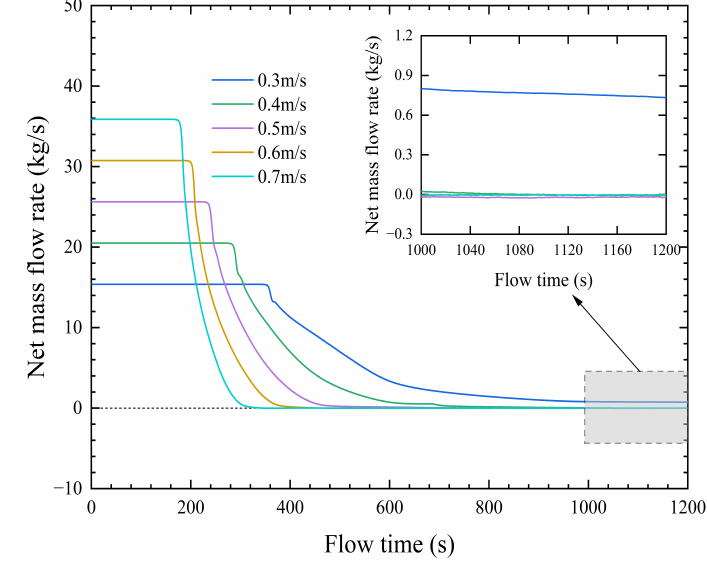
Figure 6. Net mass flow rate changes with flow time (V-inclined pipe L = 150 m d = 0.02